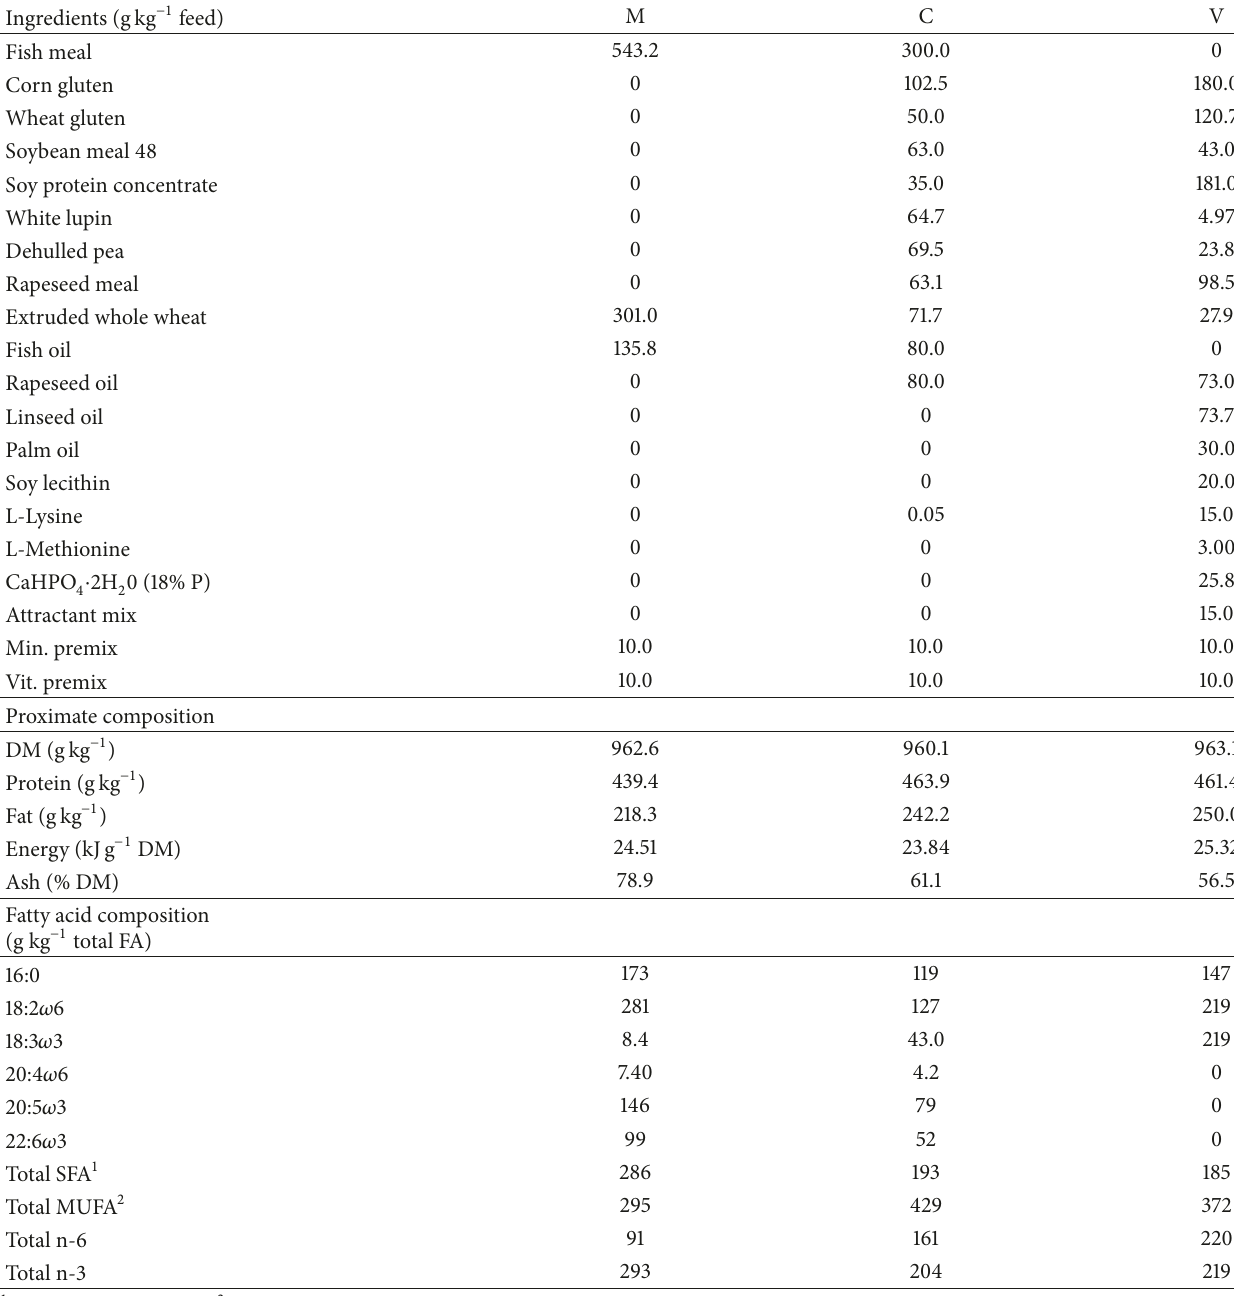
Table 1: Formulations and proximate compositions of the rainbow trout experimental diets fed from 10g to 1.1–1.5 kg. Ingredients (gkg −1